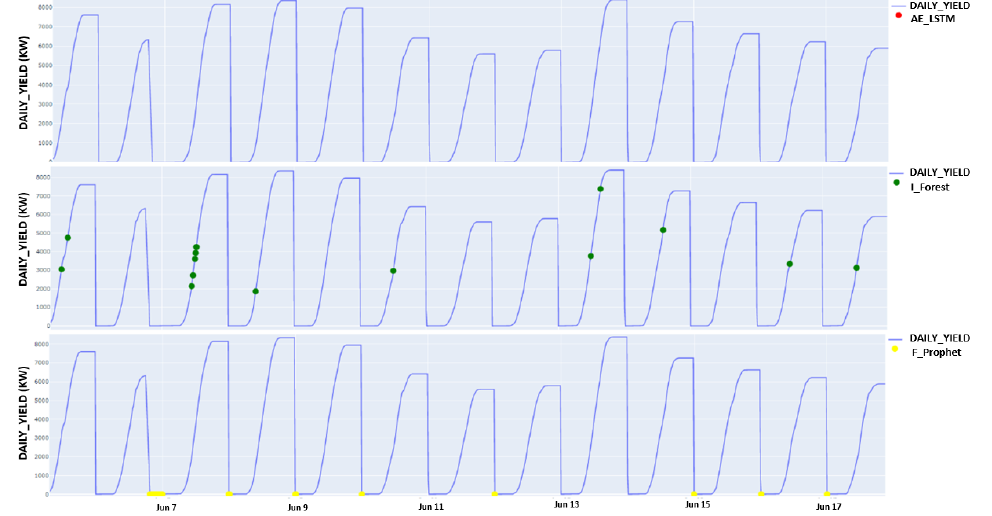
Figure 10. Anomaly detection outcomes from the three models on a healthy daily yield